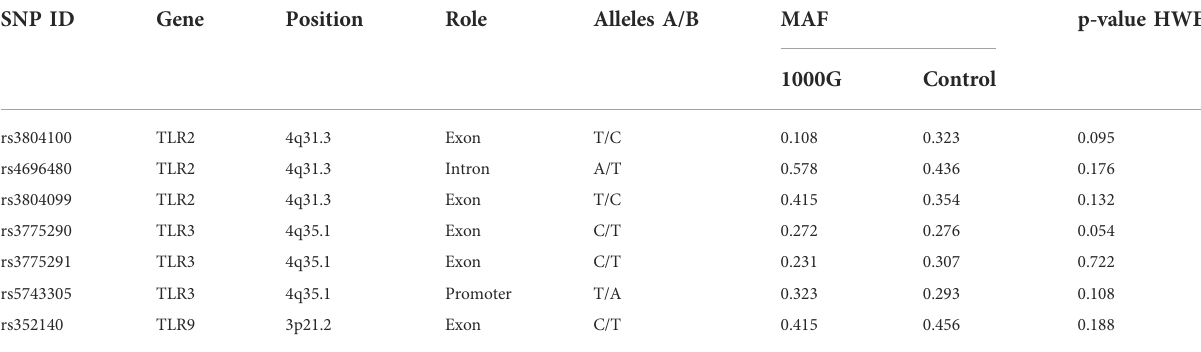
TABLE 3 Characteristics of the SNPs in this